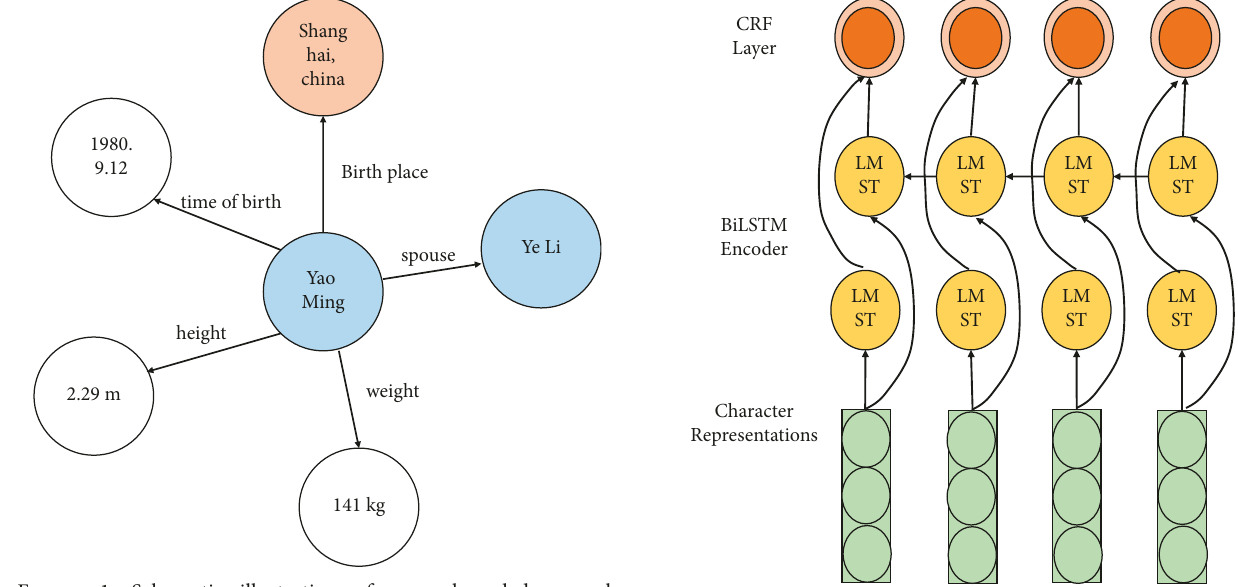
Figure 2: BiLSTM-CRF neural network model structure.